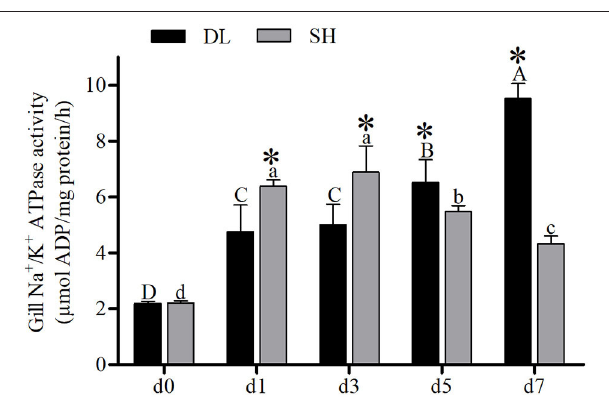
FIGURE 2 | Gill NKA activity ( n = 9) of DL (the alkali form introduced from Lake Dali Nor) and SH (the freshwater form introduced from Songhua River) fish forms acclimated to AW (alkaline water) for 7 days. Different uppercase letters indicate significant differences within DL, and different lowercase letters indicate significant differences within SH. The asterisk (*) denotes a significant difference found in NKA activity between DL and SH exposed to bicarbonate